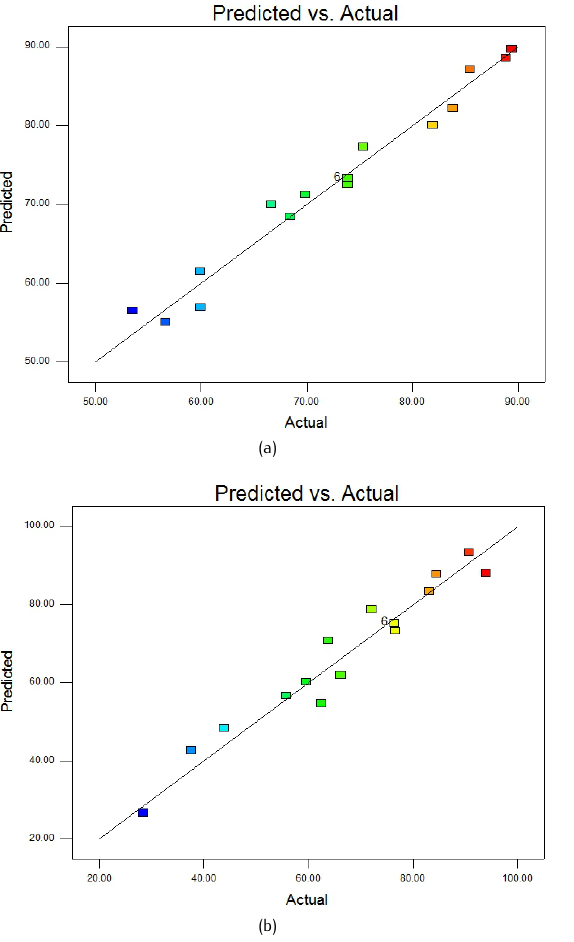
Figure 2. The actual and predicted values for the biodecolourization of RTB (a) and RB5 (b) dyes.